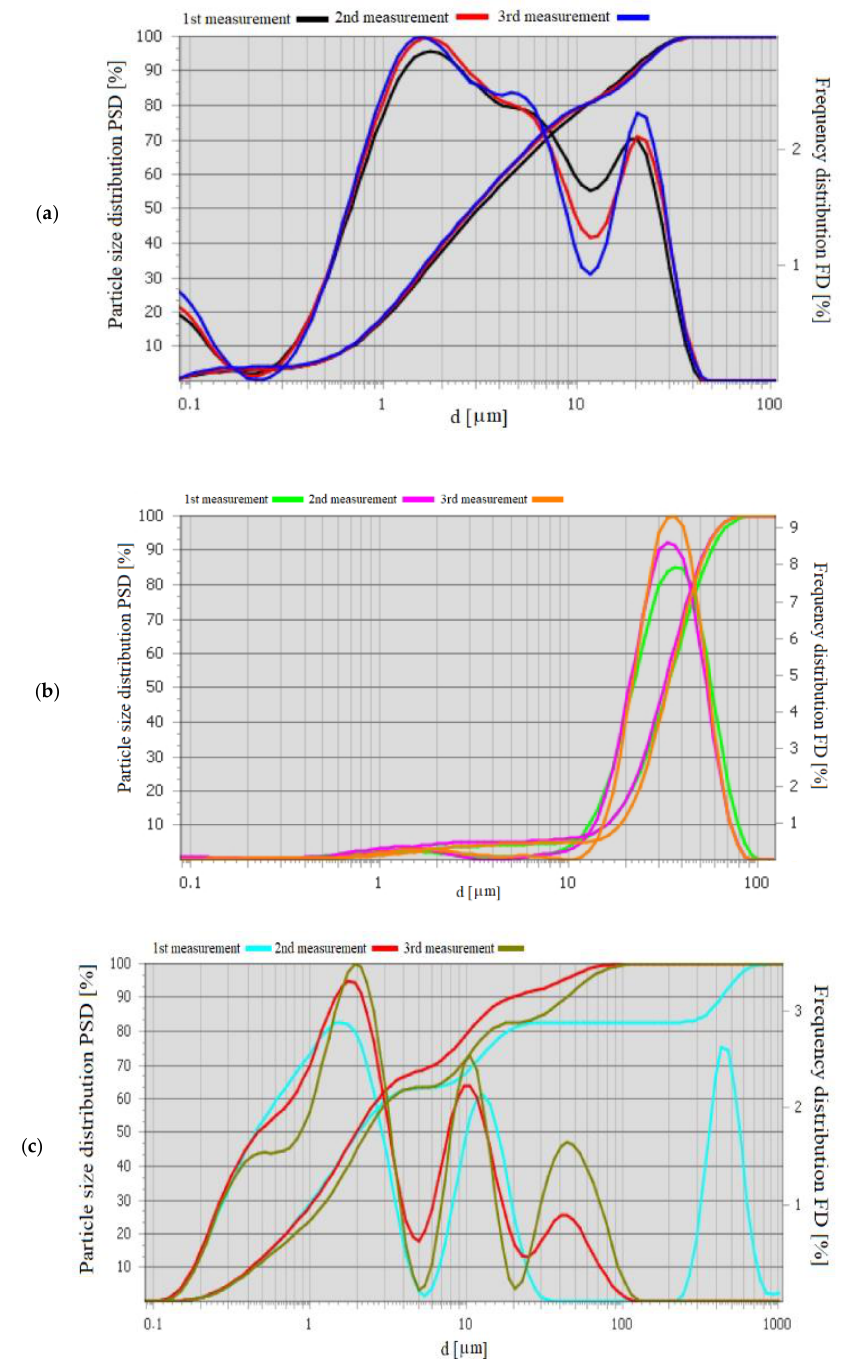
Figure 3. Graph of dependency PSD = f ( d ) for the studied building materials: ( a ) building gypsum, ( b ) artificial gypsum before the calcination process, ( c ) artificial gypsum after the calcination process.